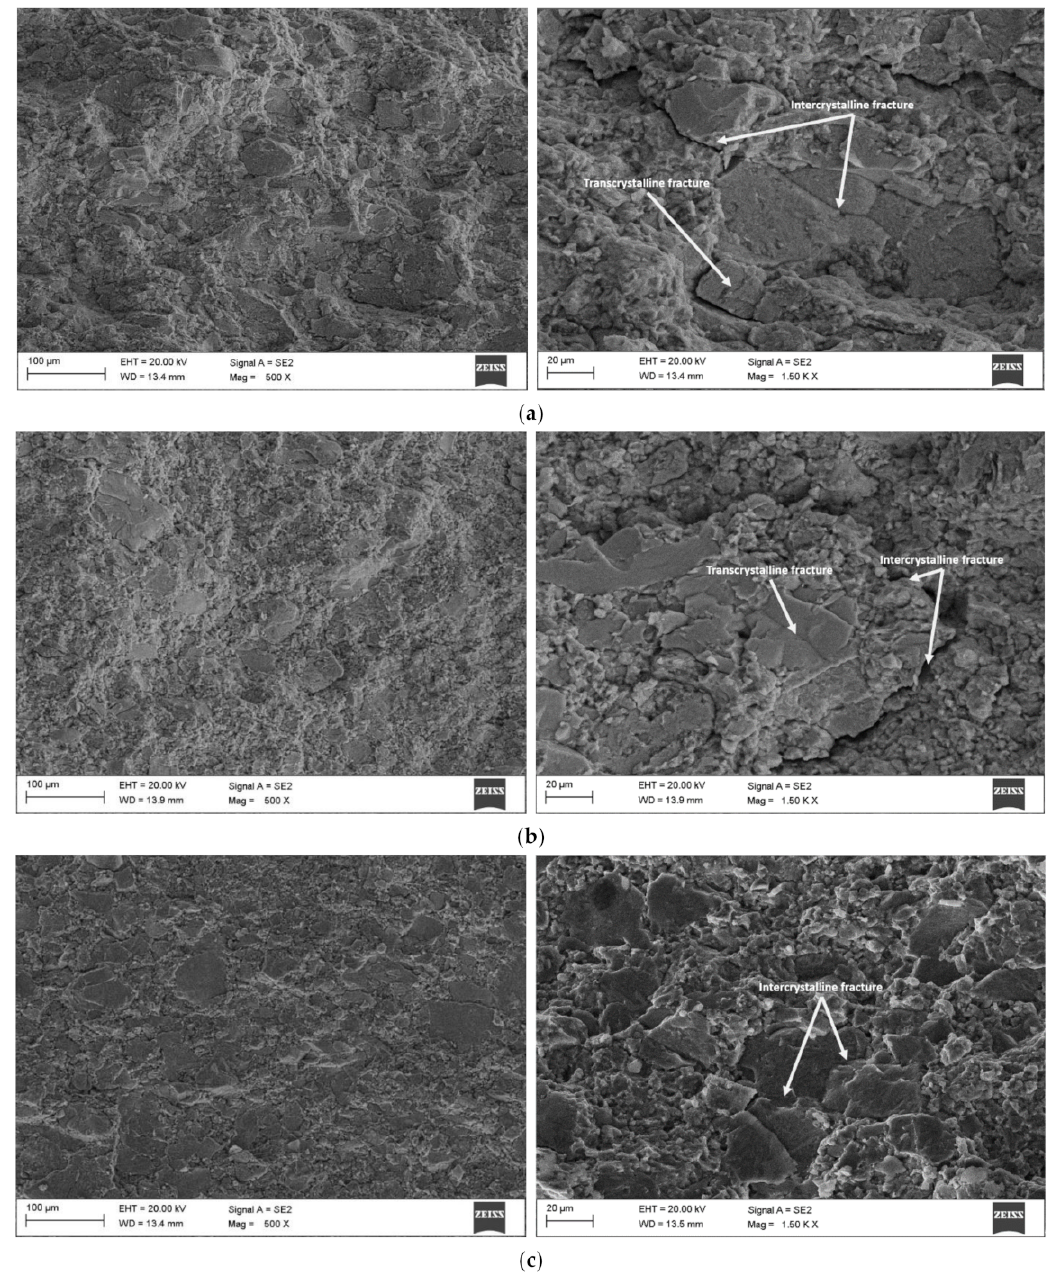
Figure 8. Scanning electron microscope micrographs of specimens of the Mg-Zn-Ca-Pr alloy after the three-point bending test for samples milled for ( a ) 13, ( b ) 20, and ( c ) 70 h,